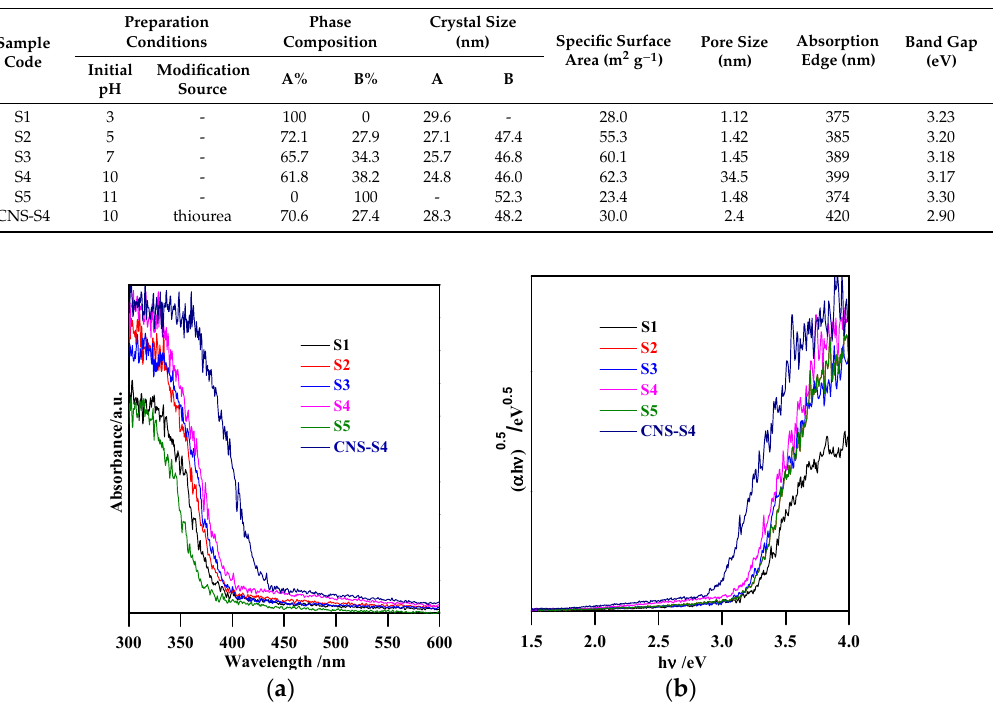
Figure 3. ( a ) diffuse reflectance spectra of S1, S2, S3, S4, S5 and CNS-S4; ( b ) curves of ( α h ν ) 0.5 versus h ν .